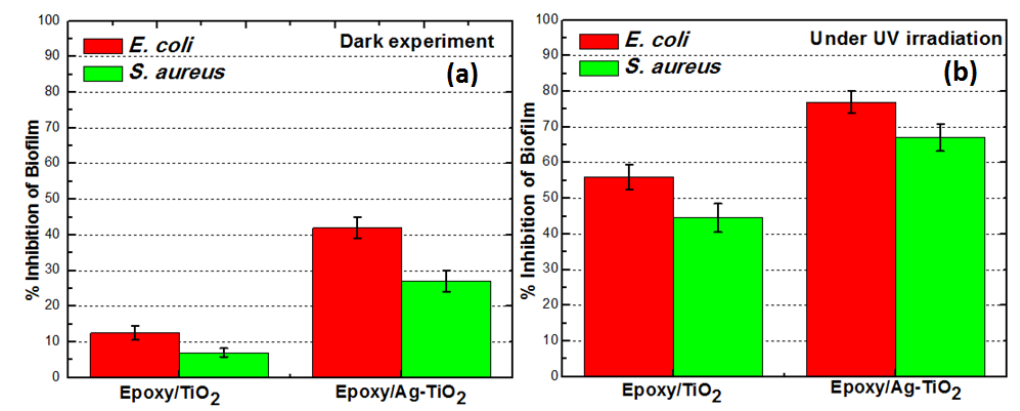
Figure 7. Mean values of quadruplicate experiments showing percent inhibition of E. coli and S. aureus bio-film formation on epoxy/TiO 2 and epoxy/Ag-TiO 2 composite surfaces calculated relative to the neat epoxy (negative control), under ( a ) dark and ( b ) UV irradiated